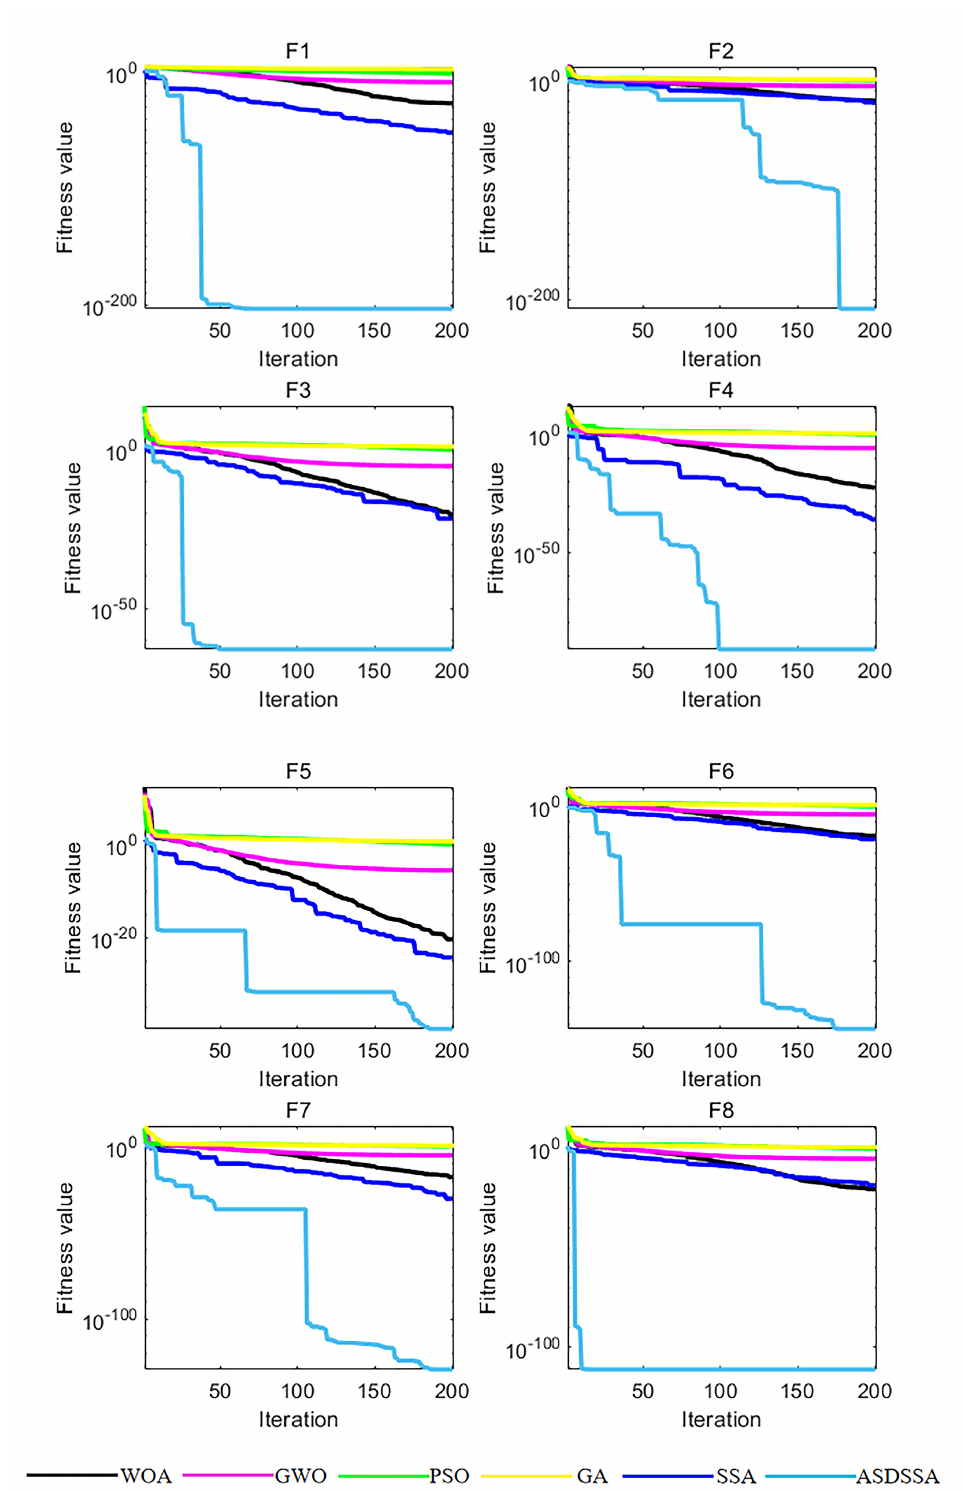
Figure 3. Convergence curves of test functions f 1 ( x ) – f 8 ( x )